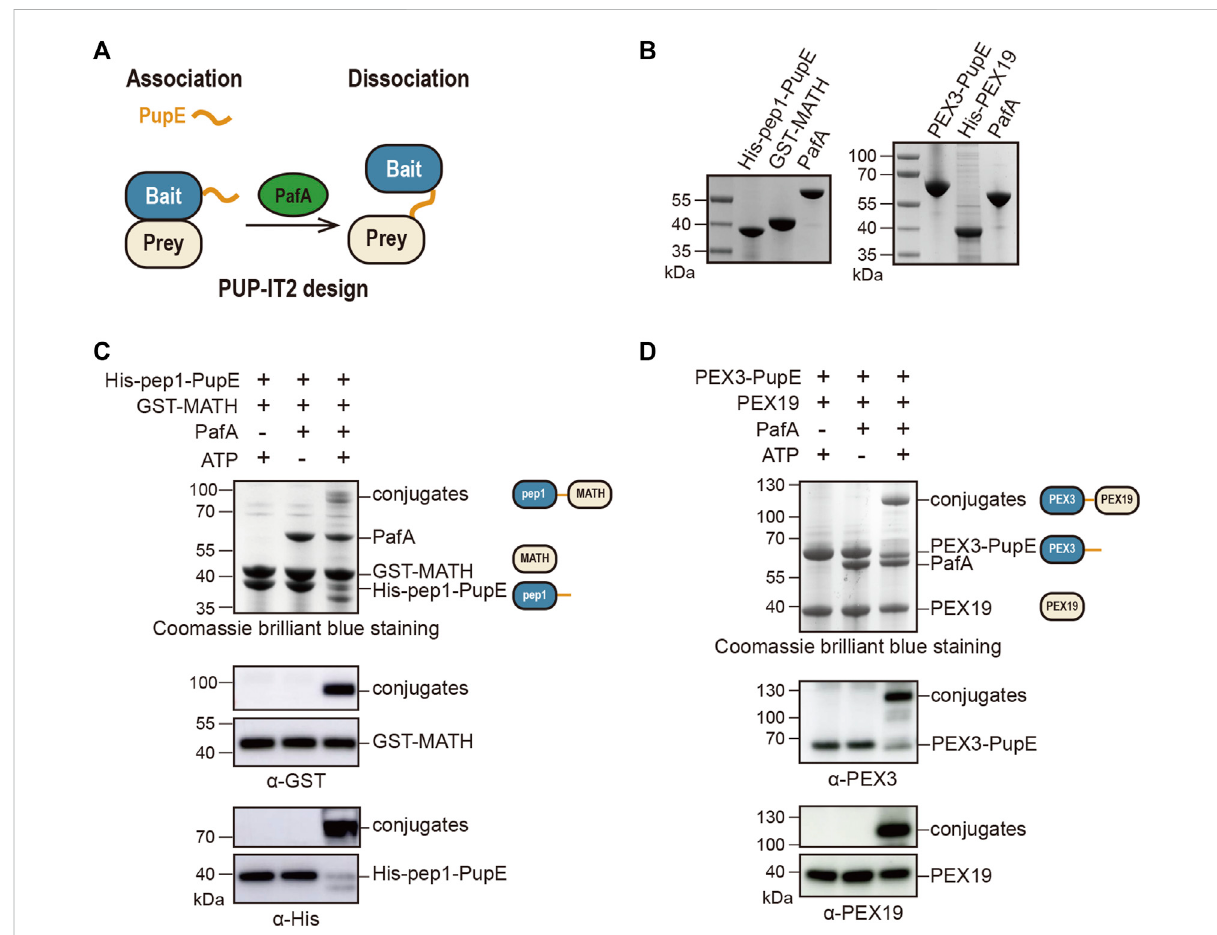
FIGURE 1 Design and validation of the PUP-IT2 proximity-tagging system. (A) Schematic of the PUP-IT2 design. BCCP-PupE (orange) is fused to a bait protein (blue), PafA (green) mediates the covalent attachment of PupE to prey proteins (yellow). (B) Coomassie brilliant blue staining of recombinant proteins His-SUMO-BCCP-pep1-PupE (labeled as His-pep1-PupE), GST-MATH, PafA, His-SUMO-Myc-PEX3-PupE (labeled as PEX3-PupE) and His- PEX19.6µgproteinswereloadedoneachlane. (C) Invitro Pupmodi fi cationassayofPUP-IT2 pep1 .Usingrecombinantproteinspuri fi edasshown in (B) to setup the in vitro reaction at37 ° Cfor 30 min 10µMHis-pep1-PupE and10 µMGST-MATHwereusedfor thereaction.Proteins areanalyzed with SDS-PAGE for Coomassie stain and western blotting, using anti-His and anti-GST antibodies. Schematics are shown next to the protein bands with thesame colorcode inFigure 1A to indicate thebaitand prey proteins inthereaction system. (D) Invitro Pup modi fi cation assay ofPUP-IT2 PEX3 . Using recombinant proteins puri fi ed as shown in (B) to set up the in vitro reaction at 37 ° C for 30 min 10 µM PEX3-PupE and 10 µM His-PEX19 were used for the reaction. Proteins were analyzed with SDS-PAGE for Coomassie stain and western blotting, using anti-PEX3 and anti-PEX19